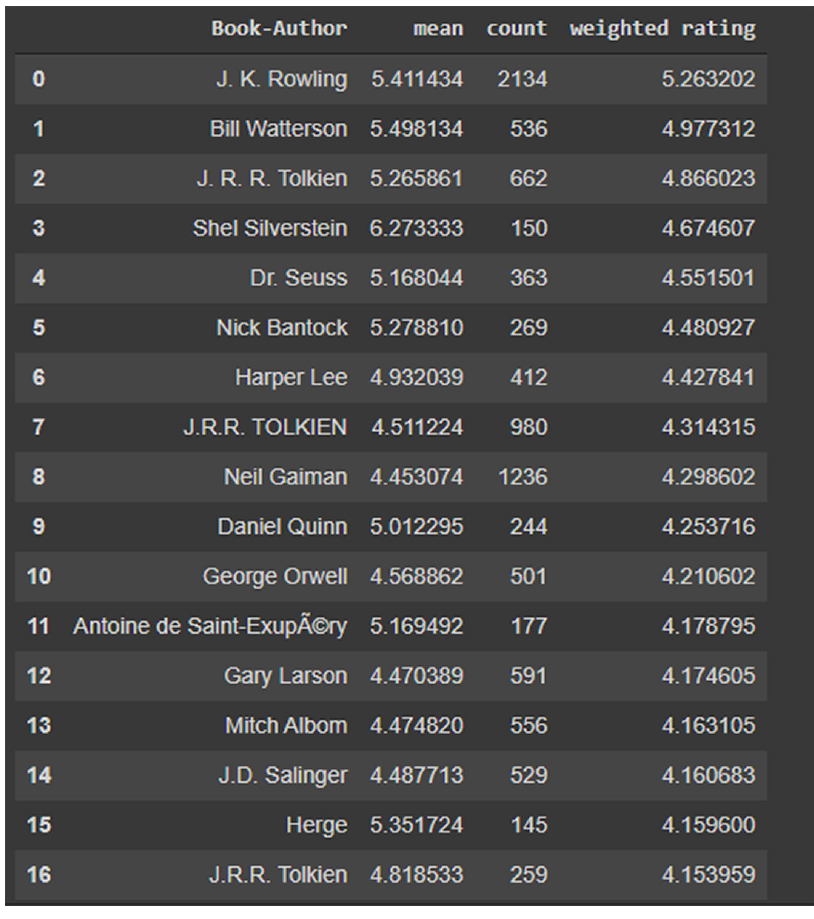
Fig. 3. List of top 20 author ratings